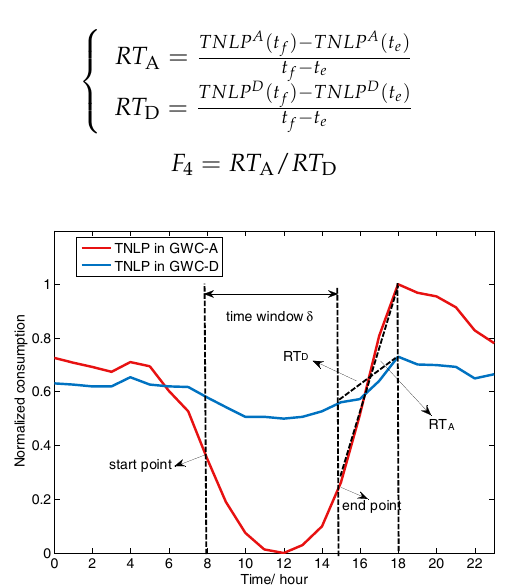
Figure 6. Illustration of the load ramping.